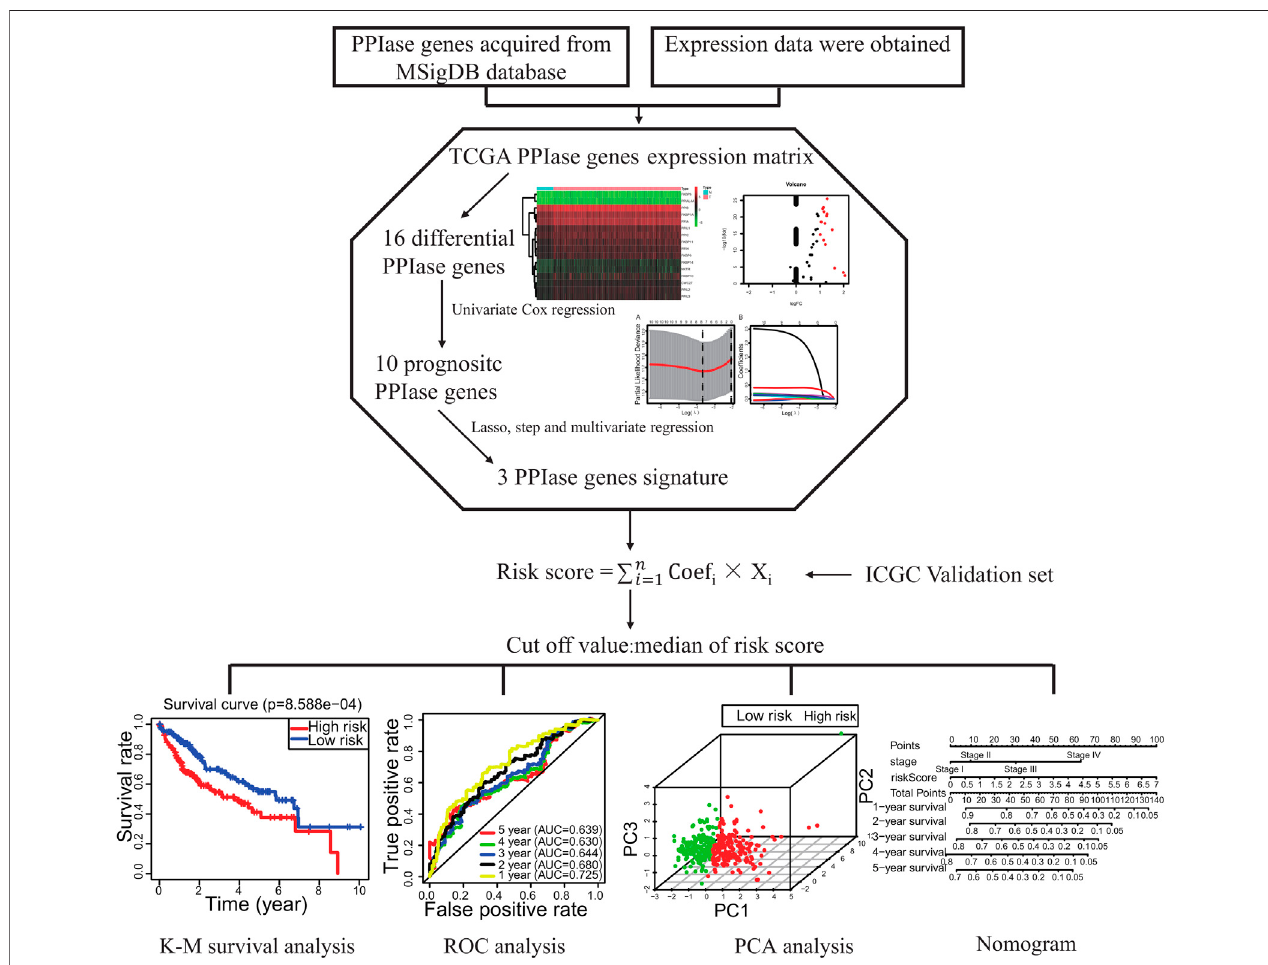
FIGURE 1 | Flowchart for pro fi ling the peptidyl prolyl cis – trans isomerase gene signatures.